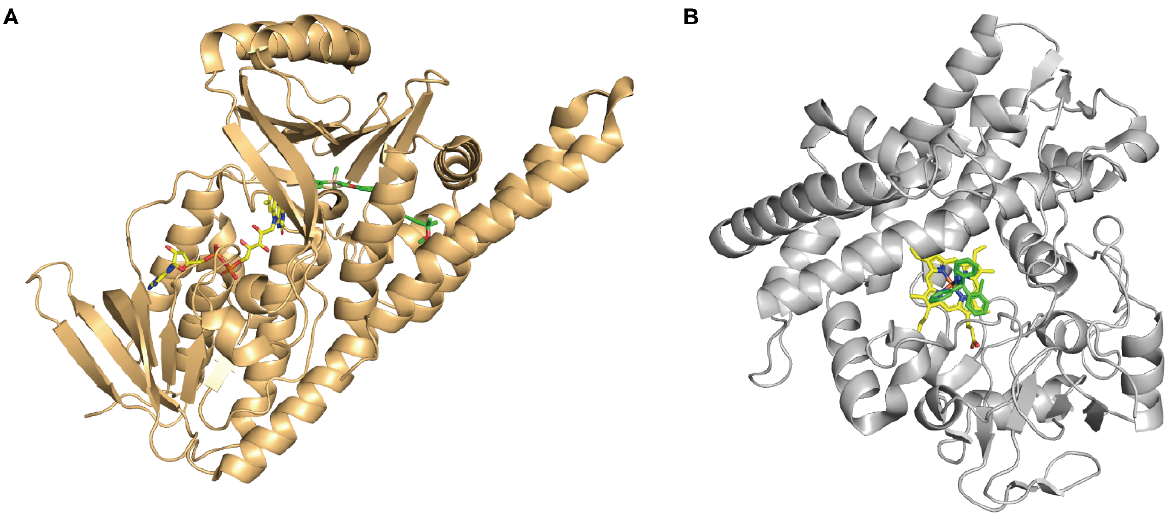
Figure 1 . Crystal structures of human SQLE ( A ) and OleP from Streptomyces antibioticus ( B ). SQLE is presented as cartoons in orange. FAD (yellow) and NB-598 (green) are shown as sticks. OleP is presented as cartoons in grey. Heme (yellow) and CTZ (green) are shown as sticks.